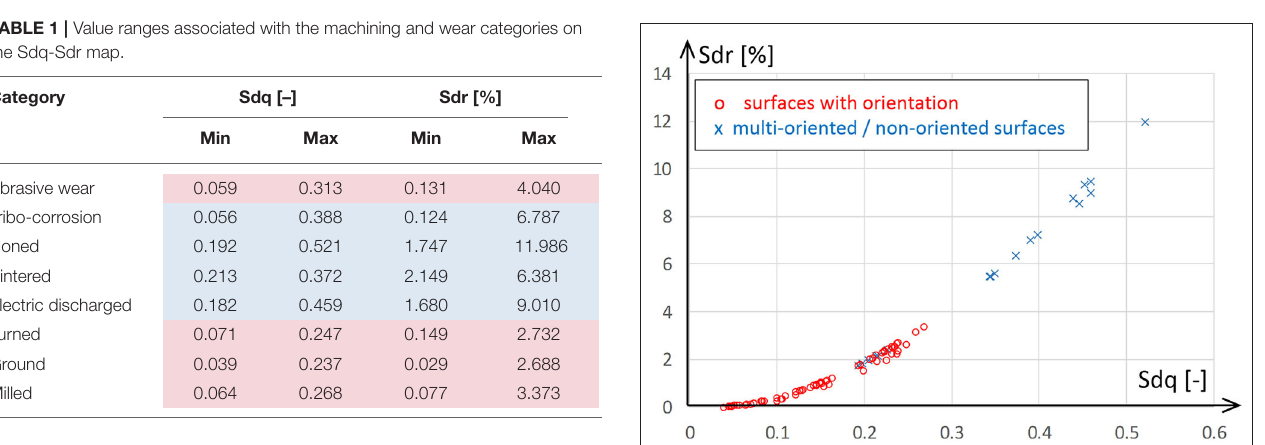
By analyzing Table 1 , it is conspicuous that in respect of machining, surfaces with orientation fall within the smaller Sdq and Sdr range (red background). Figure 3 shows the map by grouping the types of machining. The red circles show oriented types of machining (turned, ground, milled), while the blue x-es show multi-oriented or non-oriented machining